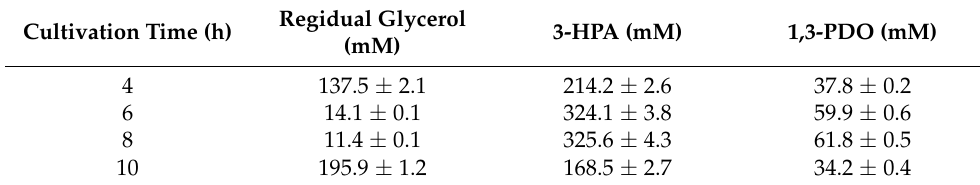
Figure 1. The neighbor-joining phylogenetic tree of Lactobacillus reuteri BR201 based on 16S rRNA gene sequences. The number at each branch represents the bootstrap value (%) for the node calculated from 1000 replicates. Bar: 0.01 substitutions per nucleotide. Table 1. The Effect of cultivation time on the levels of residual glycerol, 3-hydroxypropionaldehyde, and 1,3-propanediol by L. reuteri